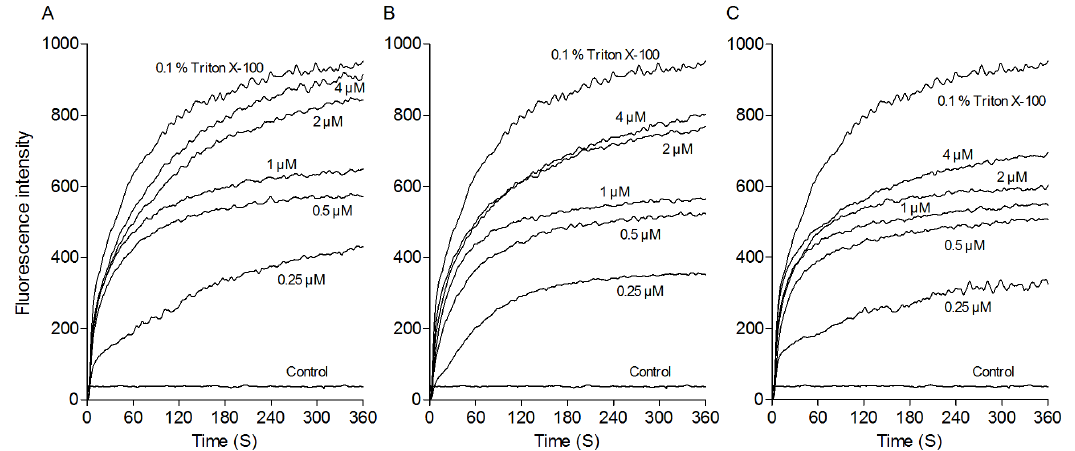
Figure 4. Cytoplasmic membrane depolarization of E.coli UB1005 by the peptides. The cytoplasmic membrane permeabilization of the peptides was measured using the membrane potential-sensitive dye, diSC 3 (5). Changes in fluorescence were recorded with an F-4500 fluorescence spectrophotometer at an excitation wavelength of 622 nm and an emission wavelength of 670 nm. (A) PMAP-36; (B) GI24; (C) melittin.